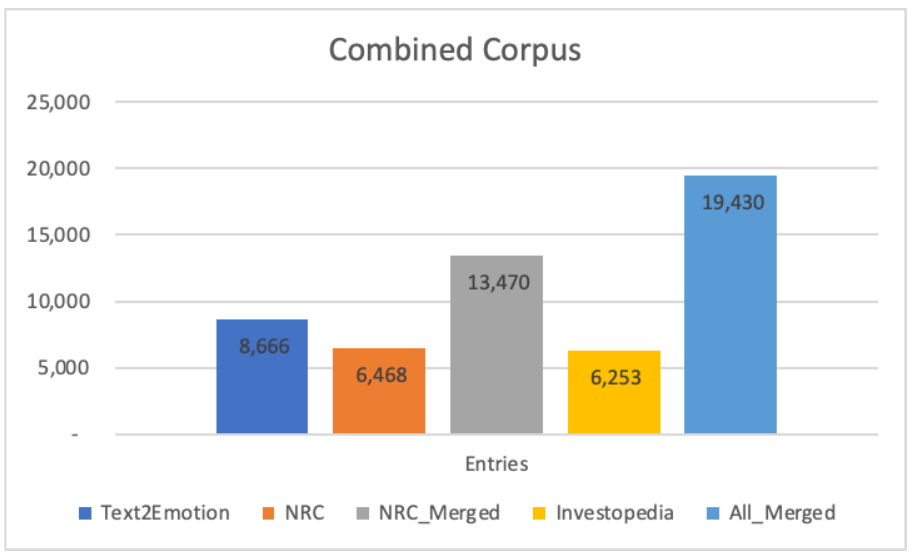
Figure 1. Expanded